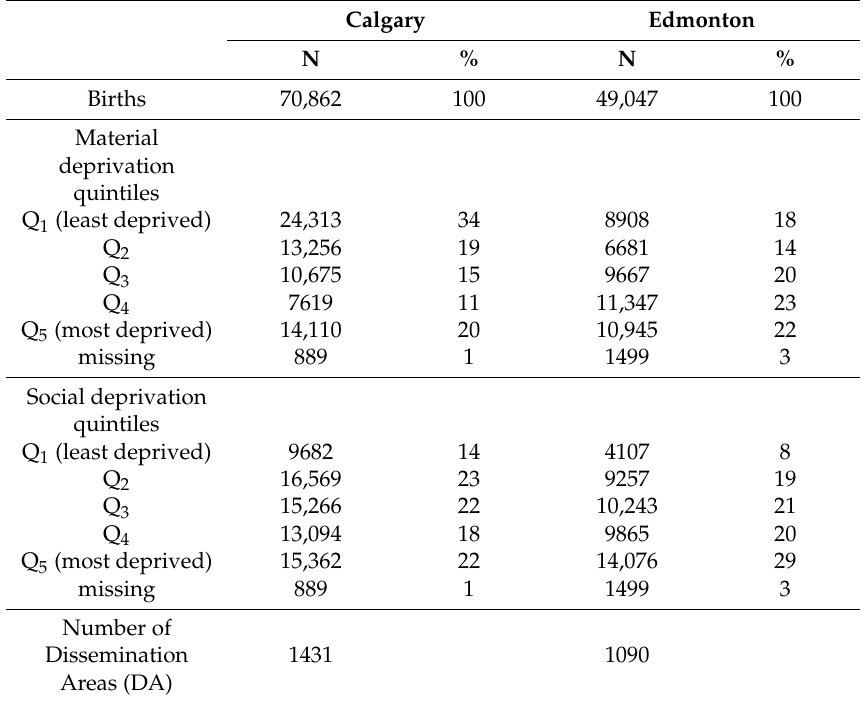
Table 1. Distribution of singleton live births across material and social deprivation quintiles and number of geographic areas (Dissemination Areas: DA) for Edmonton and Calgary. Calgary Edmonton N %